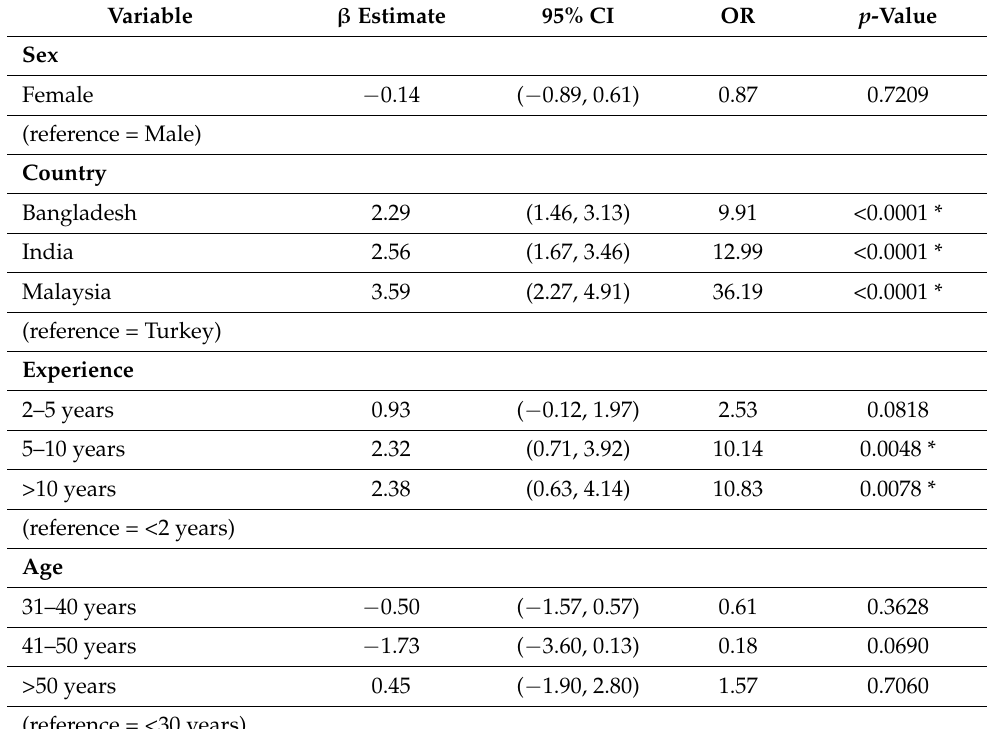
Table 4. Predictors of KAP (1 = adequate vs. 0 = inadequate) of dengue diagnosis and treatment among